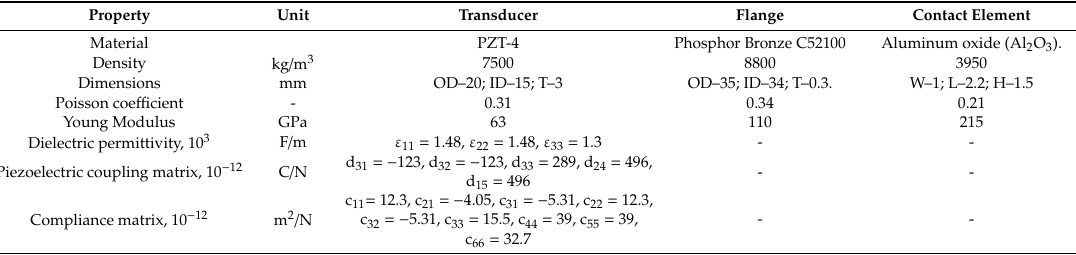
Figure 2. Dimensions of actuators and flanges: ( a ) actuator with disk-shaped flange; ( b ) actuator with triangle-shaped flange. Table 2. Dimensions and material properties of the